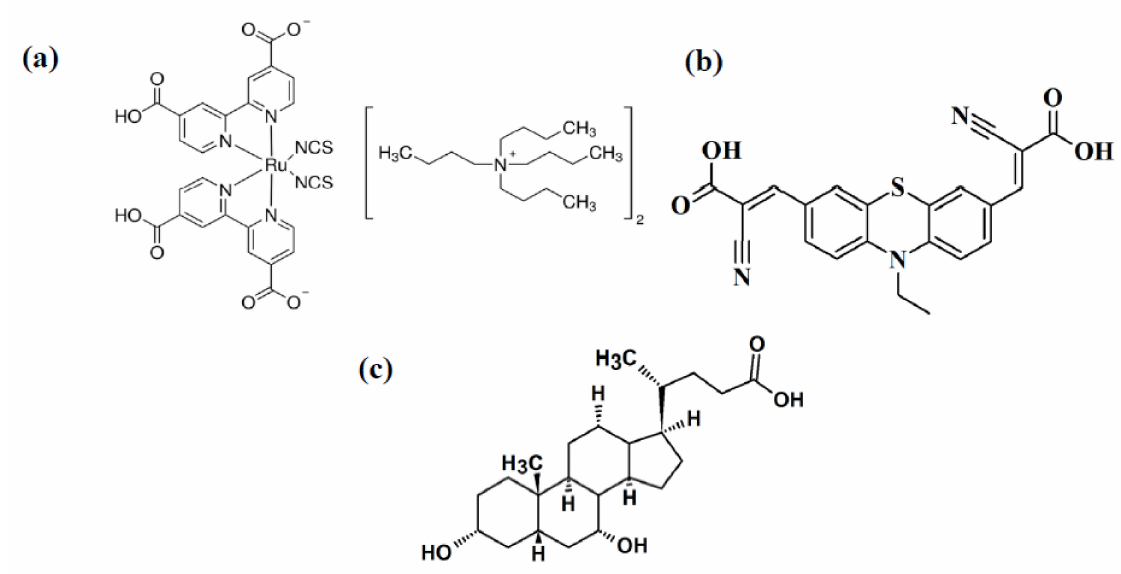
Figure 1. The chemical structures of: ( a ) N719 dyes, ( b ) AC-9, ( c ) CDCA